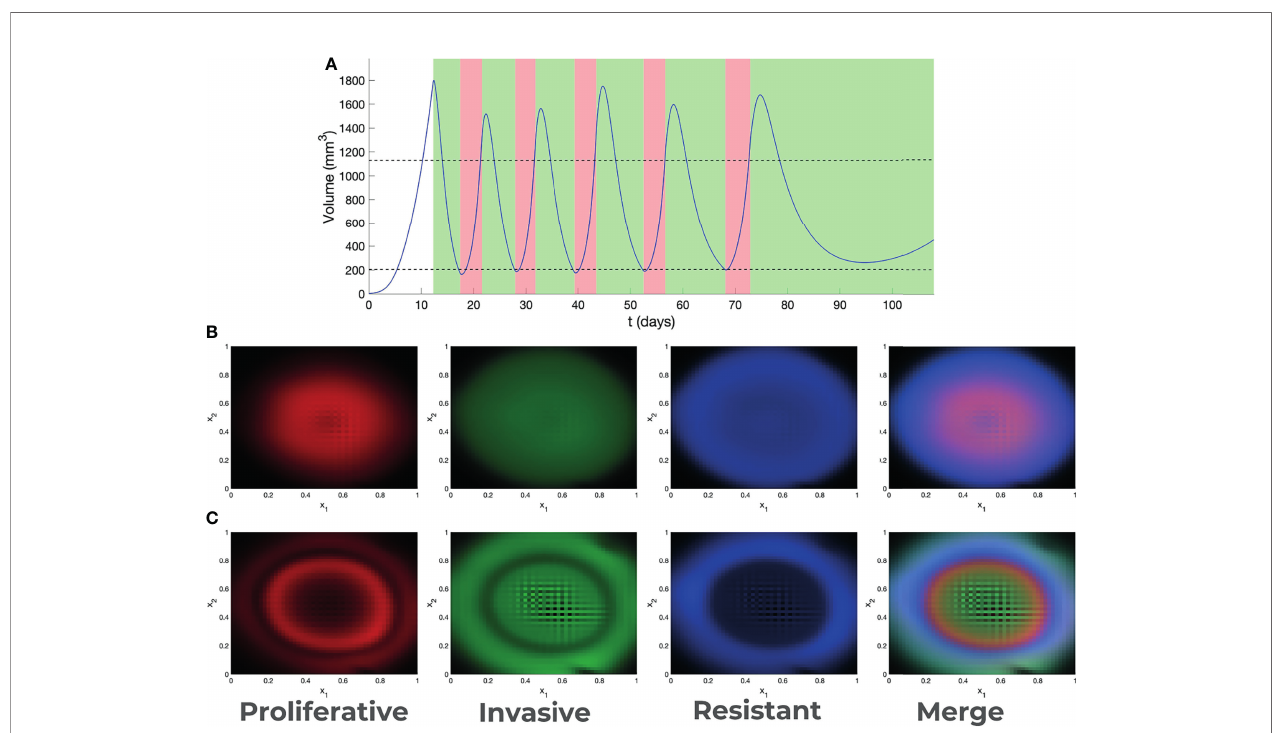
FIGURE 3 | Adaptive therapy. (A) Outcome of adaptive therapy, with BRAF/MEKi treatment intervals indicated in green and drug hollidays in pink . Decision about treatment is taken every day. Treatment is applied if the volume is higher than the upper threshold, stopped if the volume is lower than the lower threshold (thresholds are indicated as dotted lines). Spatial heterogeneity (zoning) generated by continuous (B) and adaptive (C)